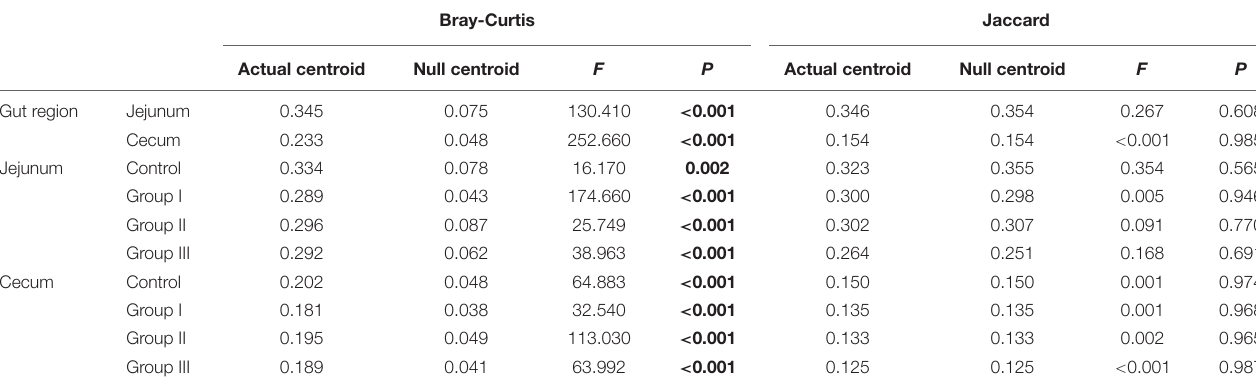
TABLE 2 | Bray-Curtis and Jaccard significance tests of centroid differences between the observed communities and the null model simulations for the four dietary groups in the cecum and jejunum. Bray-Curtis